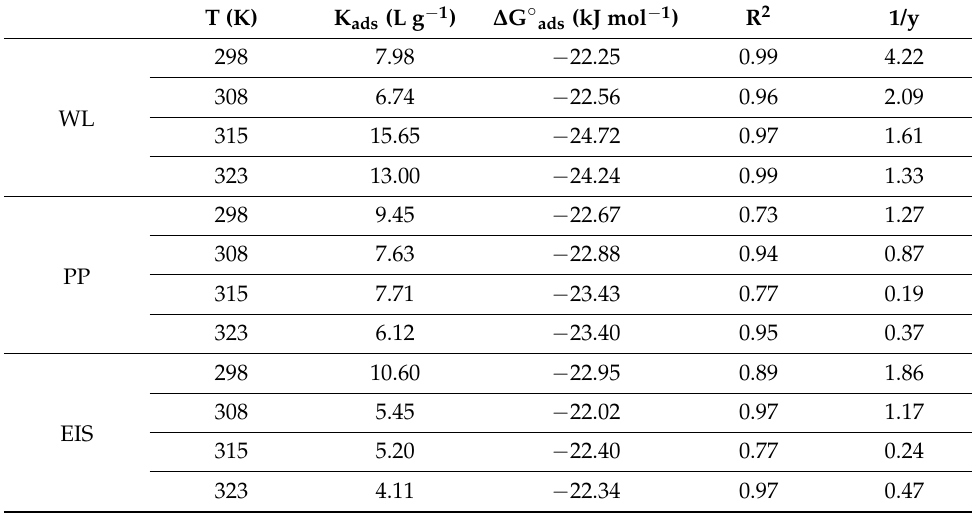
Table 5. Parameters estimates derived through regression according to the isotherm of